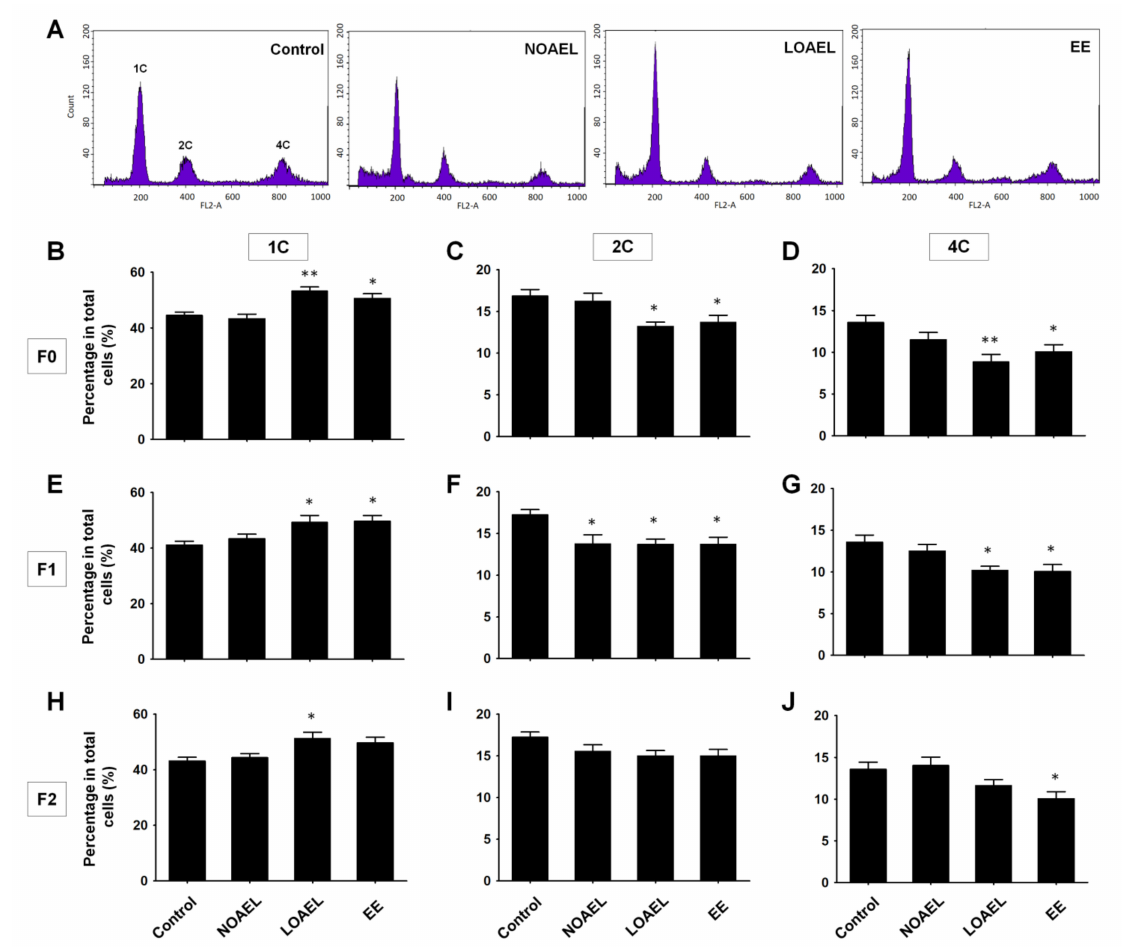
Figure 5. Bisphenol-A (BPA)-induced changes in the proportion of testicular cell populations. ( A ) Representative images of the control, BPA doses [no-observed-adverse-e ff ect-level (NOAEL), lowest-observed-adverse-e ff ect level (LOAEL)], and ethinylestradiol (EE), derived from fluorescence-activated cell sorting (FACS). Letters in the images (1C, 2C, and 4C) indicate the proportion of haploid (1C), diploid (2C), and tetraploid (4C) germ cells in the testicle. In the case of exposed group (F0), bar graphs are showing the percentage of ( B ) haploid, ( C ) diploid, and ( D ) tetraploid germ cells among the total cells. Percentage of germ cells in F1 generation; ( E ) haploid, ( F ) diploid, and ( G ) tetraploid. Percentage of germ cells in F2 generation; ( H ) haploid, ( I ) diploid, and ( J ) tetraploid. Data were analyzed by one-way analysis of variance (ANOVA) where significant di ff erences (*) were calculated as the comparison of exposed group with the control ( n = 10 mice / group; * p < 0.05 and ** p < 0.01